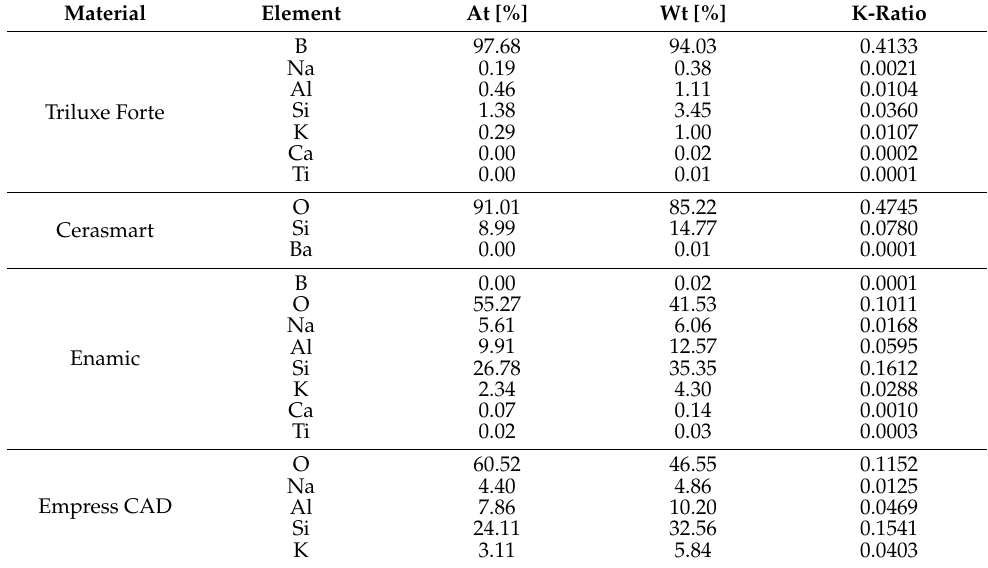
Figure 7. EDX spectra of ( A )—Enamic and ( B )—Empress CAD restorative materials, after 18 h of simulated gastric acid solution exposure. Table 5. The atomic (At) and weight (Wt) percentage values of the elements recorded on EDX spectra.